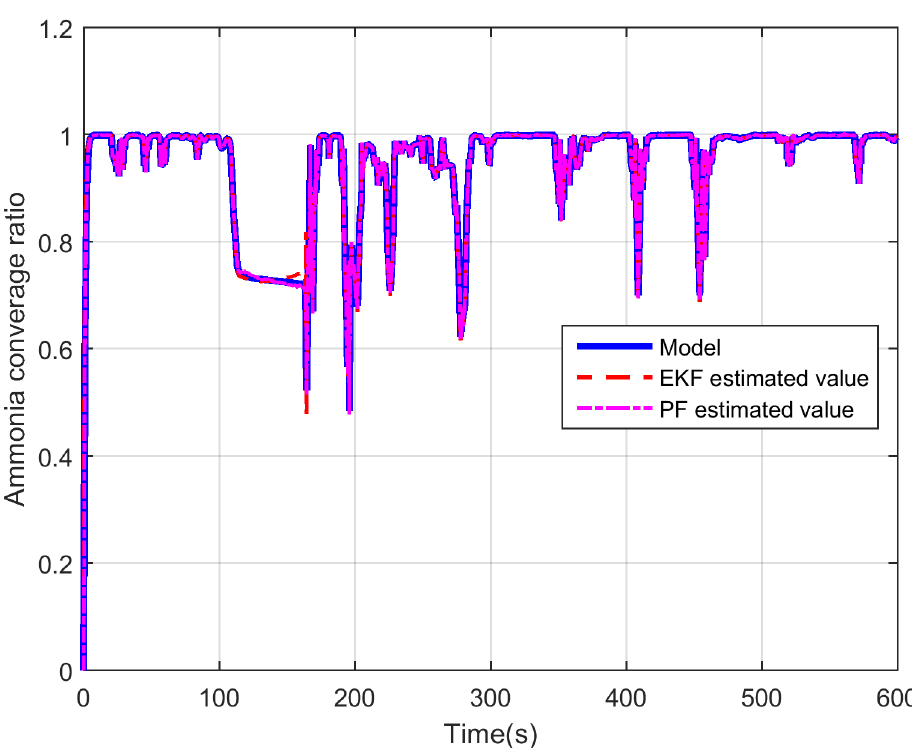
Fig 8. Comparison of model predicted ammonia coverage ratio and PF estimated ammonia coverage ratio.